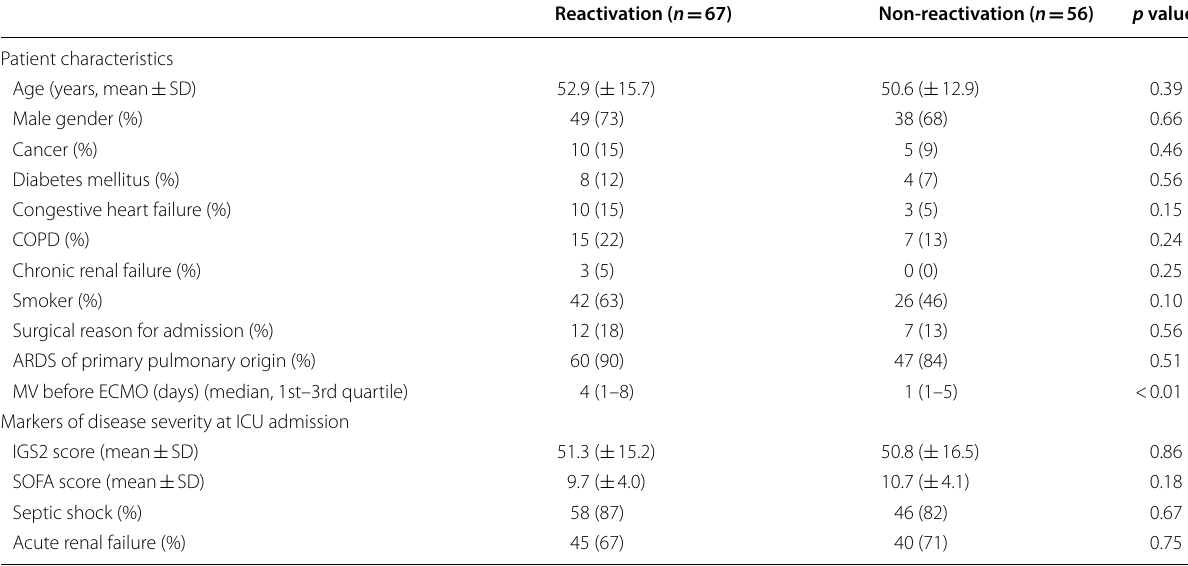
Data are presented as median and interquartile range or mean